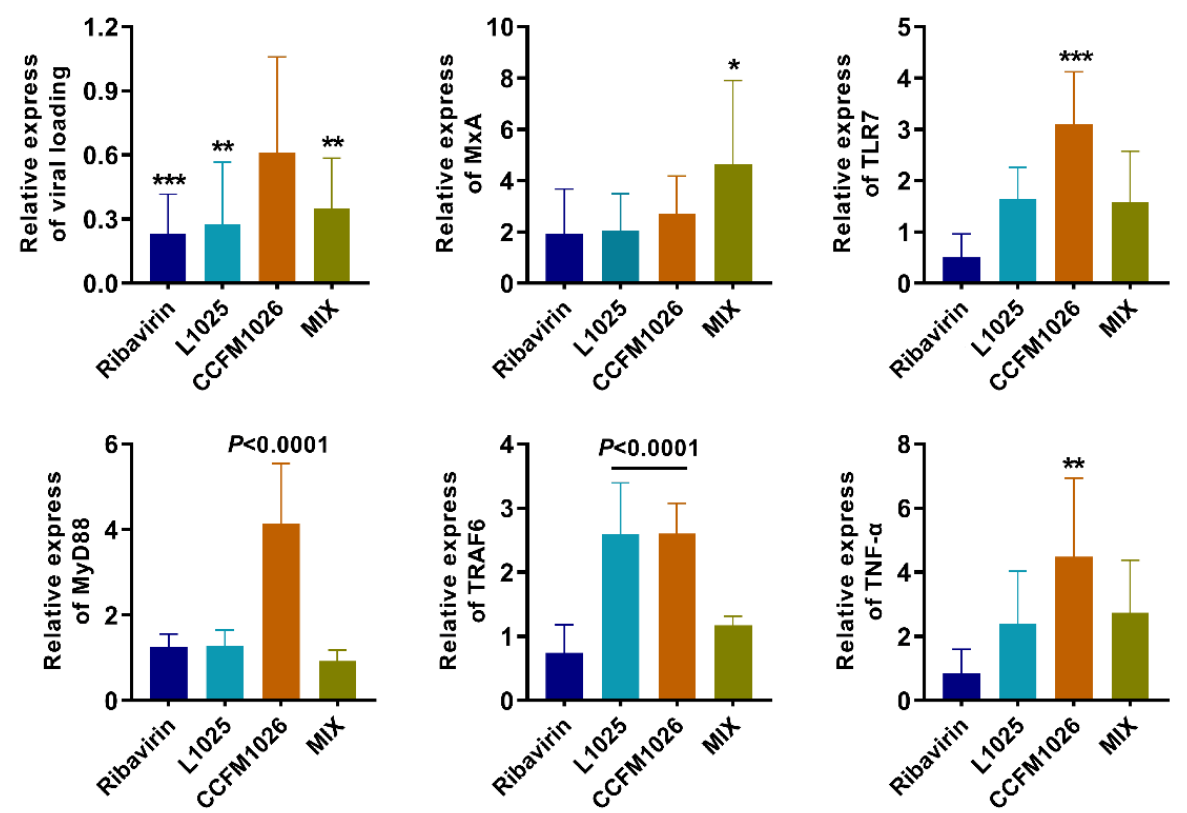
Figure 5. Alteration in indicators related to the antiviral signaling pathway. The statistical difference was evaluated using one-way ANOVA and Dunnett’s multiple comparisons test (*, **, ***, P < 0.0001 vs. the model group).